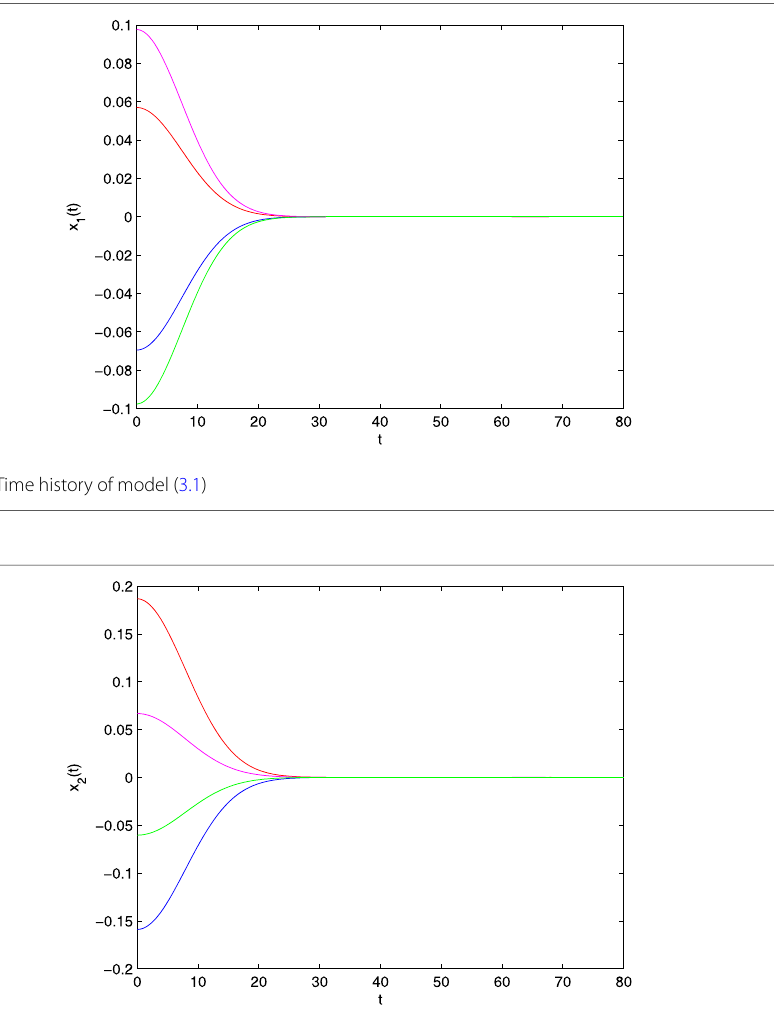
Figure 2 Time history of system (3.1)